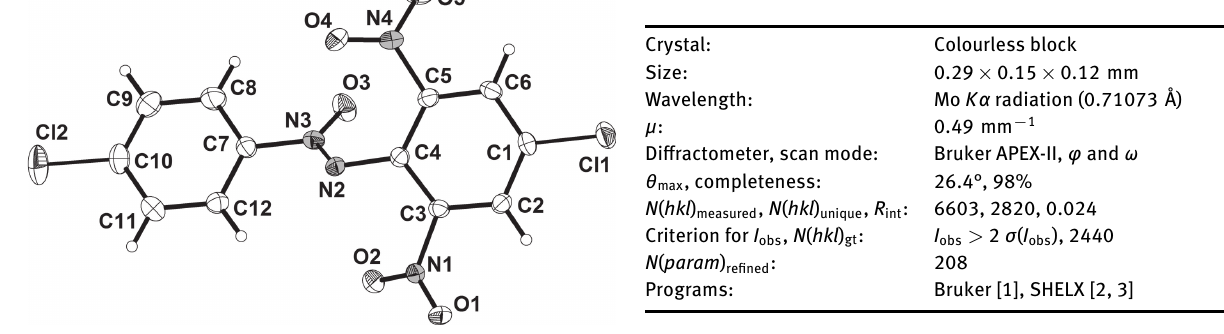
Table 2: Fractional atomic coordinates and isotropic or